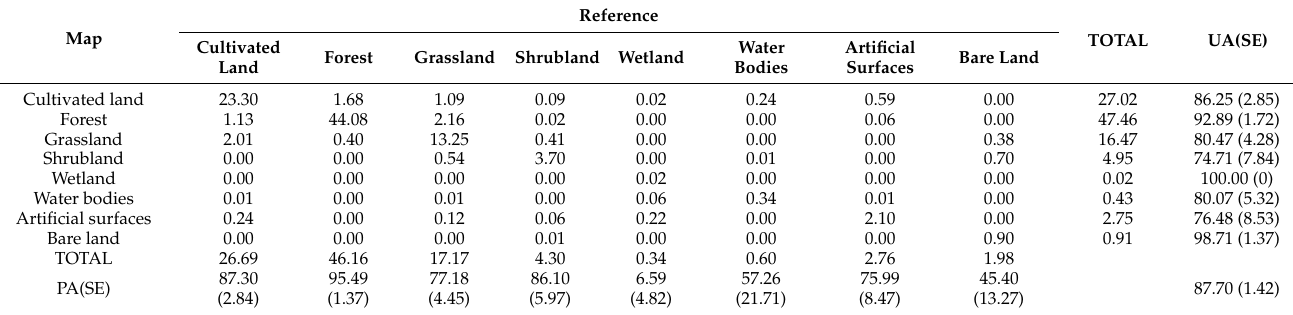
Table A15. Error matrix of fused product 2020 using localized transition